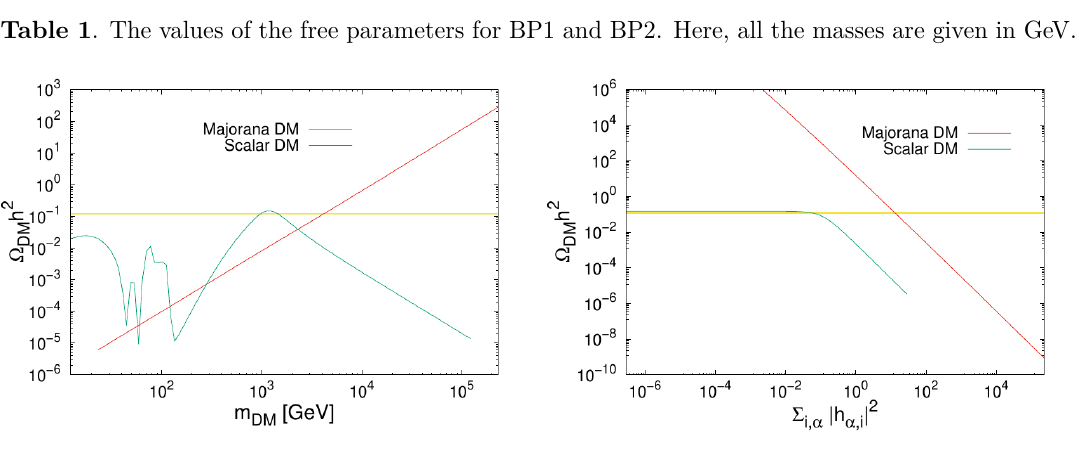
Figure 6 . The DM relic density versus the DM mass (left) and versus the couplings combination P | h α,i | 2 (right). The yellow band represents the observed the DM relic density value. One has i,α to mention that in the left panel, we make all masses changing simultaneously, i.e., all the mass fulfill the condition m = constant with all the DM mass i /m DM